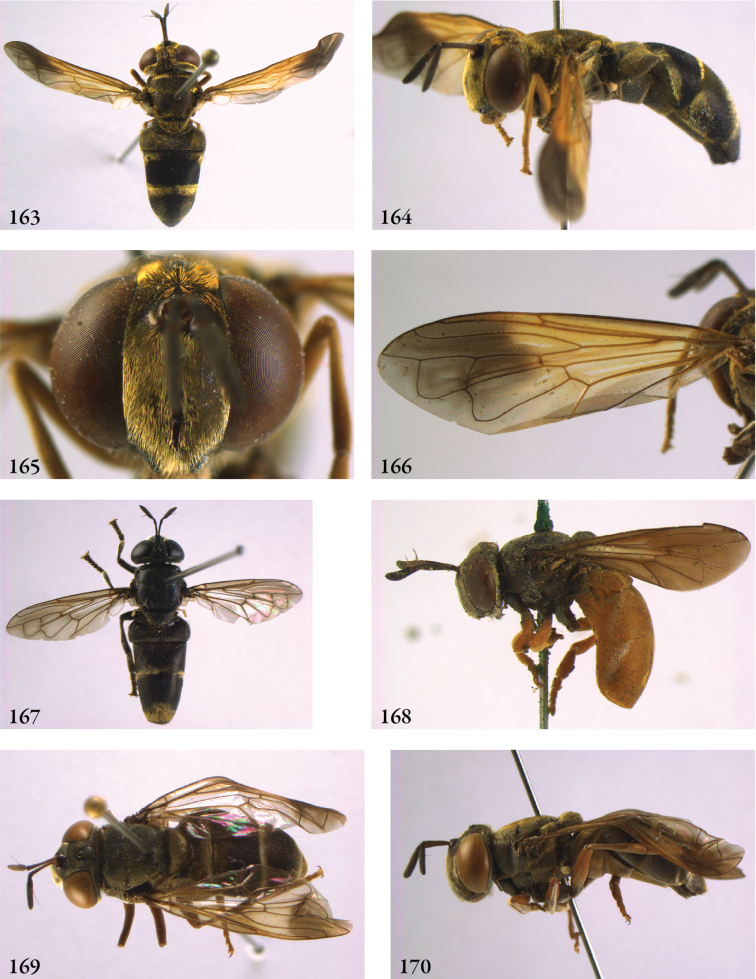
163–166
Metadon achterbergi female (holotype) 163 habitus dorsal 164 habitus lateral 165 head frontal 166 wing 167–168
Metadon, habitus: 167
Metadon bifasciatus (Japan, coll. RMNH) 168
Metadon inermis (holotype) 169–170
Metadon wulpii female (Borneo, coll. RMNH): 169 habitus dorsal 170 habitus lateral.